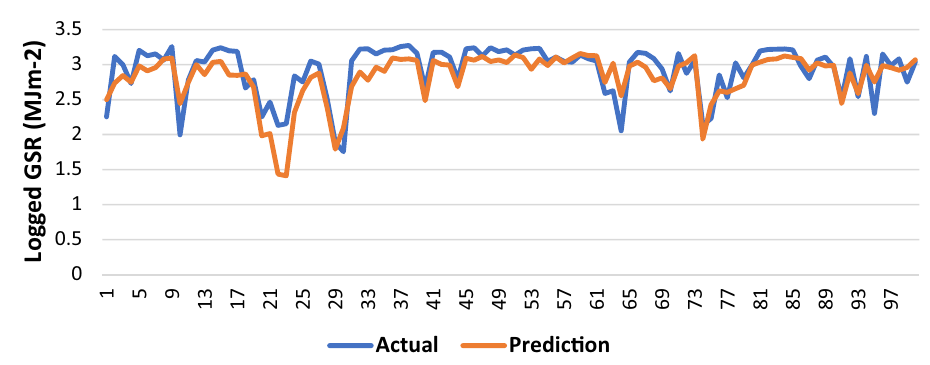
Figure 14. Graph of Actual and Predicted GSR (Model IV—BR).